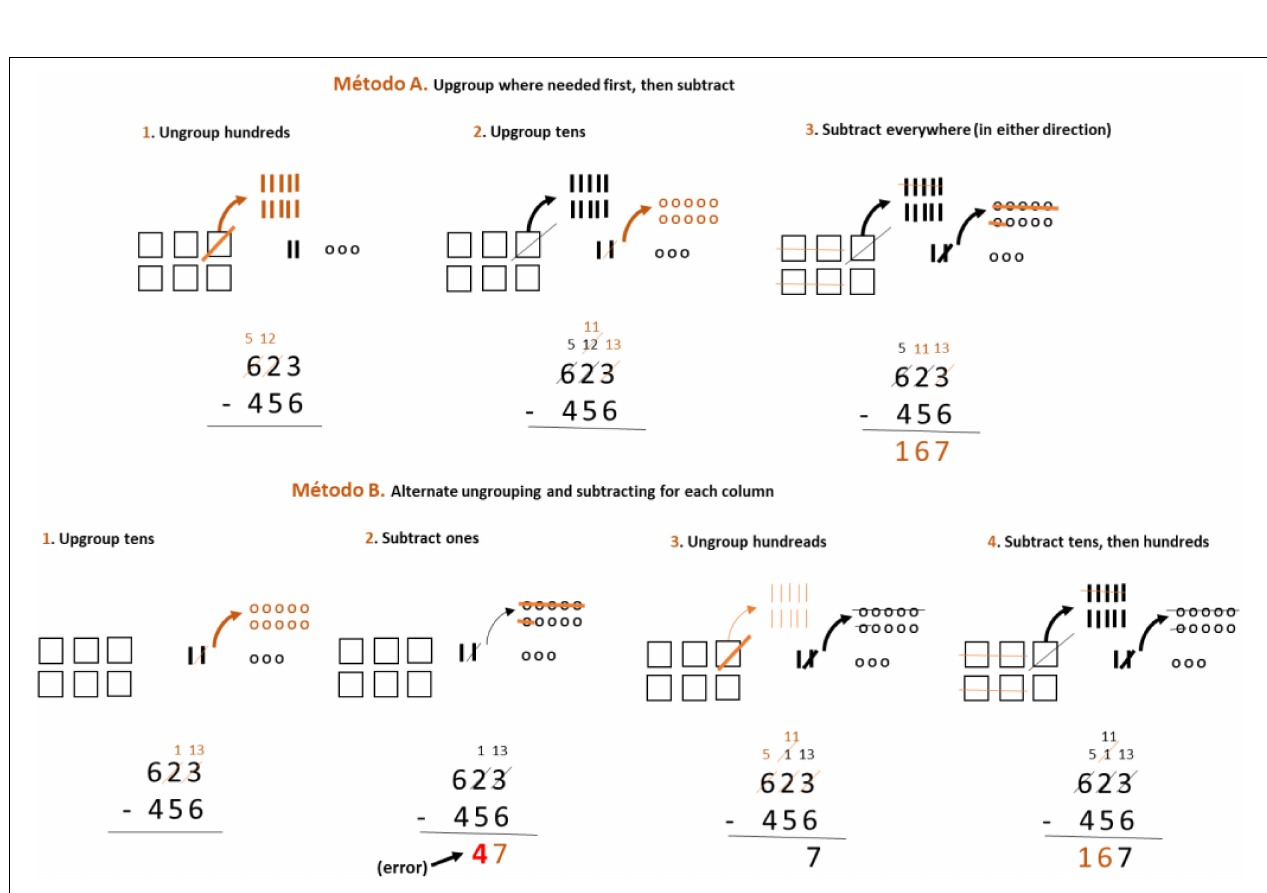
FIGURE 4 | Alternative subtraction algorithms used in the United States’s education system. Source: Fuson and Beckmann (2013, p. 21).